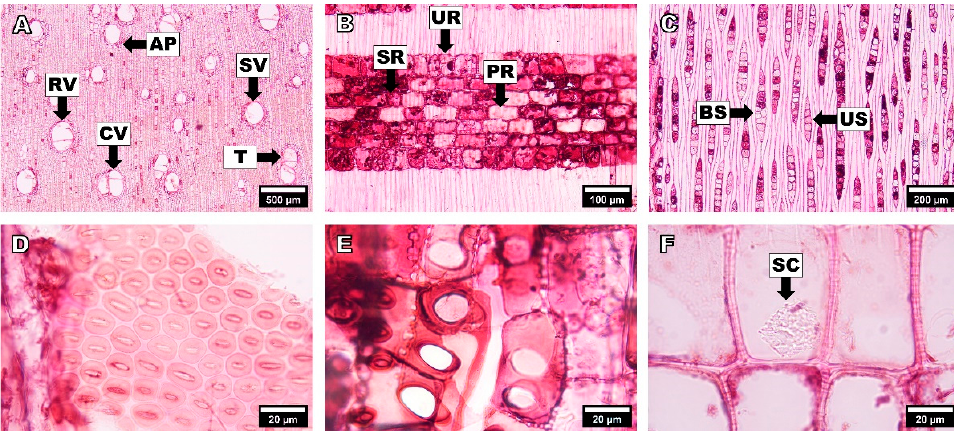
Figure 4. Optical micrographs of Anacardium occidentale . Cross-section ( A ), radial section ( B ), tan- gential section ( C ), intervessel pits ( D ), vessel-ray pits ( E ), and mineral inclusions ( F ). Solitary vessel (SV), radial vessel (RV), cluster vessel (CV), axial parenchyma (AP), tyloses (T), procumbent body ray (PR), square body ray (SR), upright body ray (UR), uniseriate ray (US), biseriate ray (BS), and silica bodies (SC).